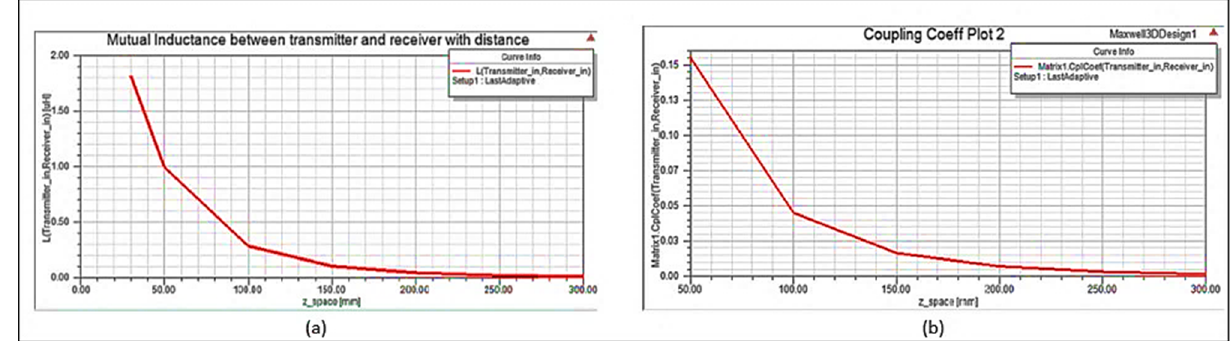
Figure 8. Results for 120 mm square coil: ( a ) mutual inductance vs. air gap spacing (mm), ( b ) coupling coefficient vs. air gap spacing (mm).